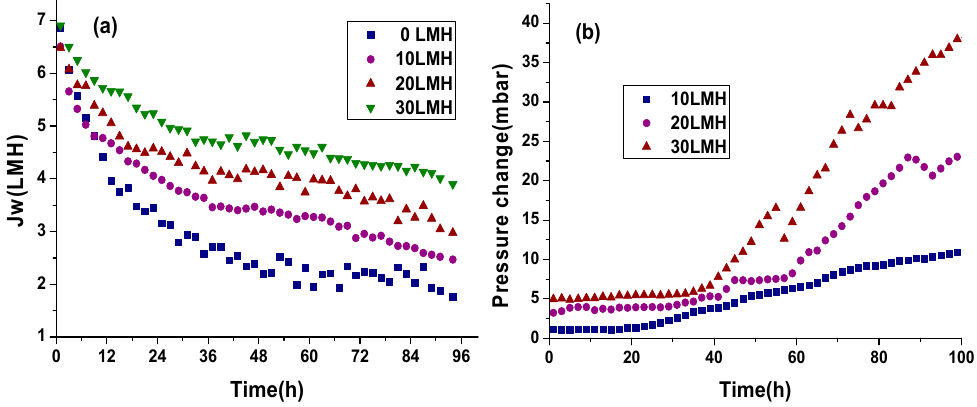
Figure 7. ( a ) Water flux of different MF imposed fluxes in the MF-FDFO-MBR hybrid system; and ( b ) MF outlet pressure change in the MF-FDFO-MBR hybrid system (DS: SOA; Feed solution: Synthetic wastewater; DS concentration: 1 M; DS flow rate: 200 mL/min, Temperature: 22 ± 0.5 °C).